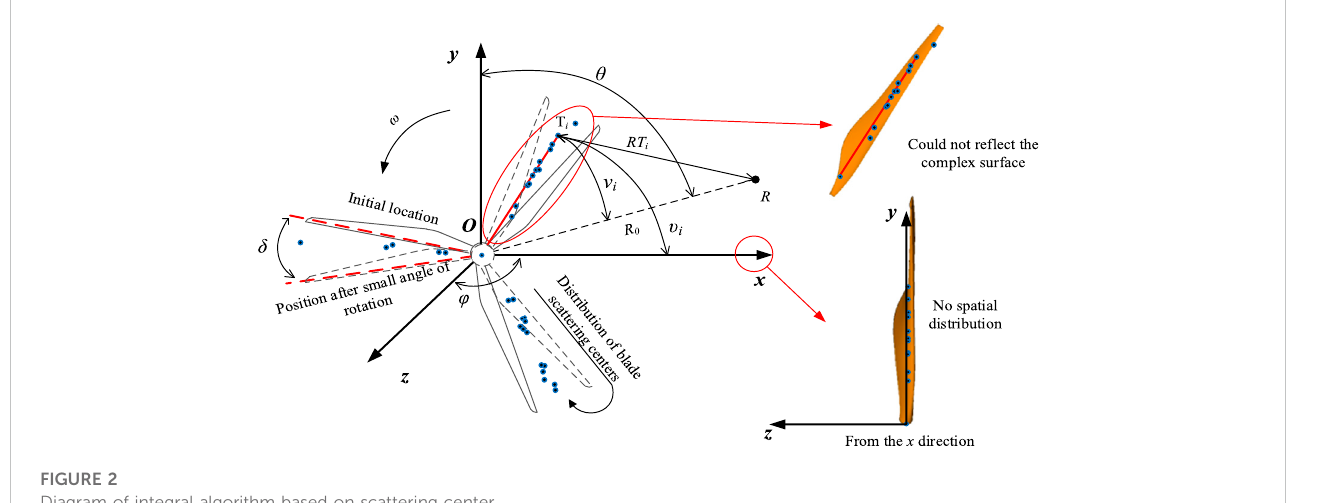
FIGURE 2 Diagram of integral algorithm based on scattering